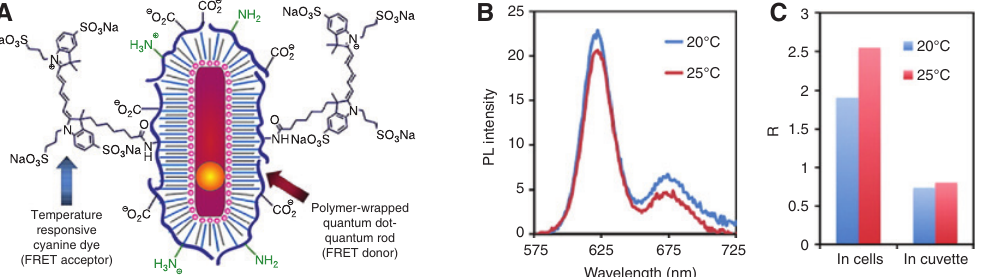
Figure 19: Quantum dot/quantum rod-based nanothermometer for intracellular thermometry. (A) Chemical structure of the nanothermometer. A red-emitting CdSe-CdS quantum dot/quantum rod semiconductor nanocrystal (center) was passivated with an amphiphilic polymer shell and a far-red emitting cyanine dye. (B) Photoluminescence (PL) spectra in living HeLa = 400 nm). (C) Photoluminescence intensity ratio ( R = FI cells ( λ ex Reproduced with permission from Albers et al. (2012). Copyright 2012 American Chemical